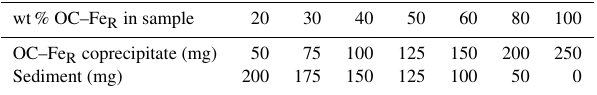
Table 2. Concentration matrix of spiked